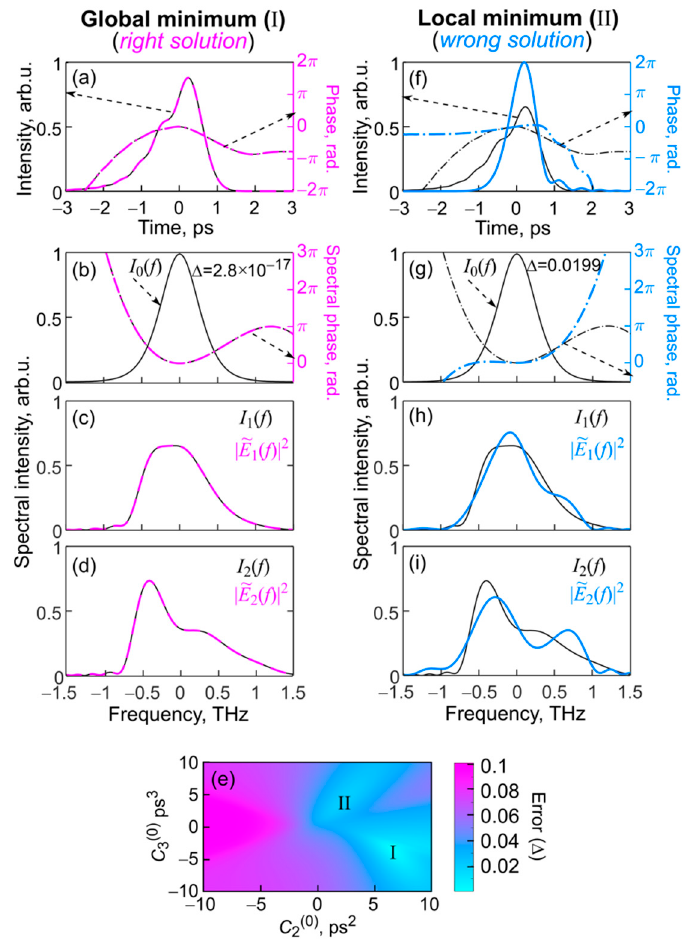
Figure 2. Search for polynomial spectral phase (“ideal” case). (( a – d ), left column) “Right” solution found for the global minimum I of the error function Δ ( C 2 = 6.5 ps 2 and C 3 = − 3.6 ps 3 ) shown in ( e ). (( f – i ), right column) “Wrong” solution constructed for the local minimum II of the error function Δ ( C 2 = 2.2 ps 2 and C 3 = 4 ps 3 ) shown in ( e ). ( a , f ) Intensity and phase in the time domain; ( b , g ) input pulse spectrum and spectral phase; ( c , h ) converted spectra at the output for B 1 = 1; ( d , i ) converted spectra at the output for B 2 = 2. Black curves calculated for the initial pulse and color (magenta and blue) curves correspond to numerically reconstructed pulses for subplots ( a – d , f – i ).